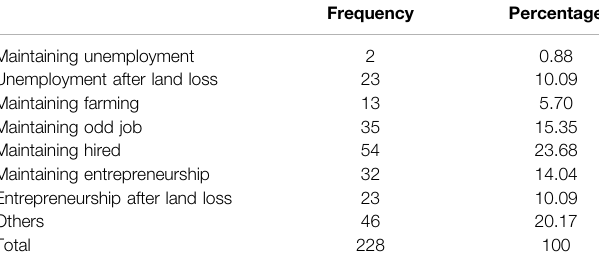
TABLE 2 | Overall employment situation of youth in the two villages before and after land loss.